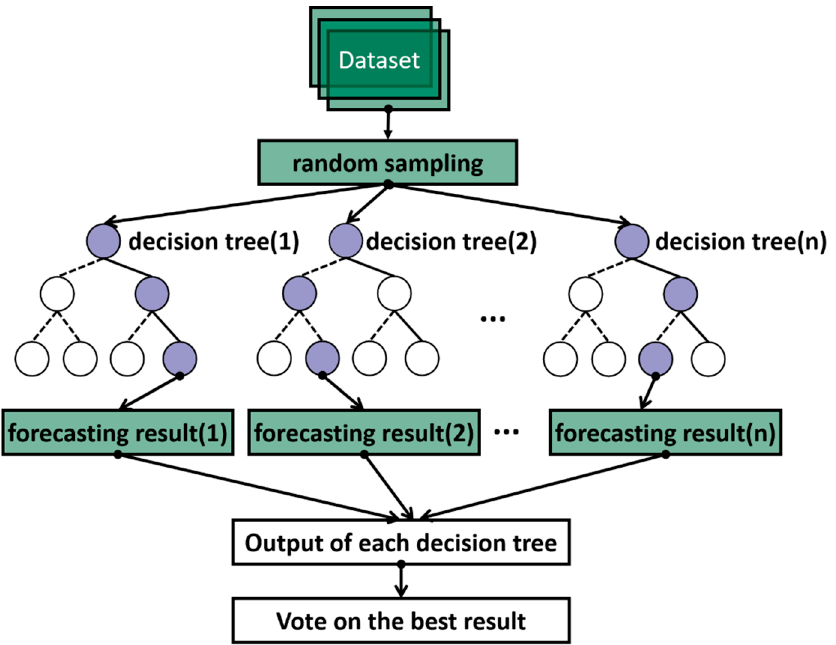
Figure 9. The schematic diagram of the RF algorithm.